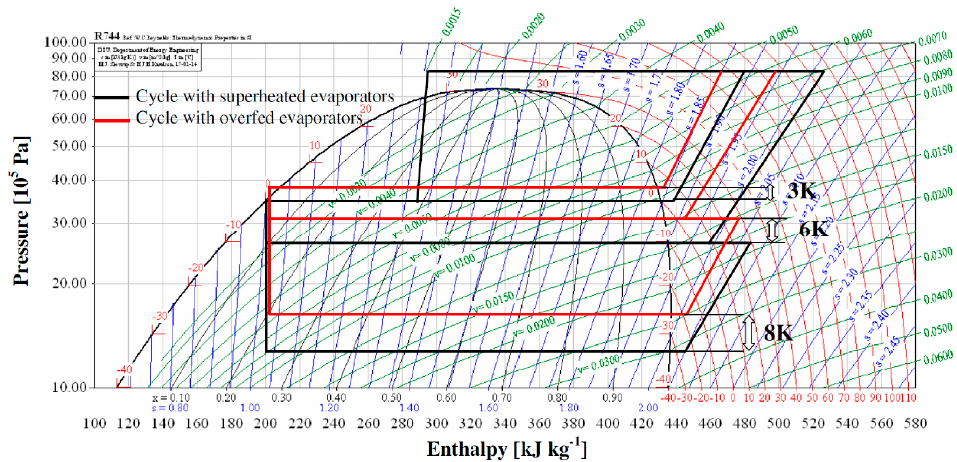
Figure 18. Comparison between the thermodynamic cycle with superheated evaporators and that with overfed evaporators [17].